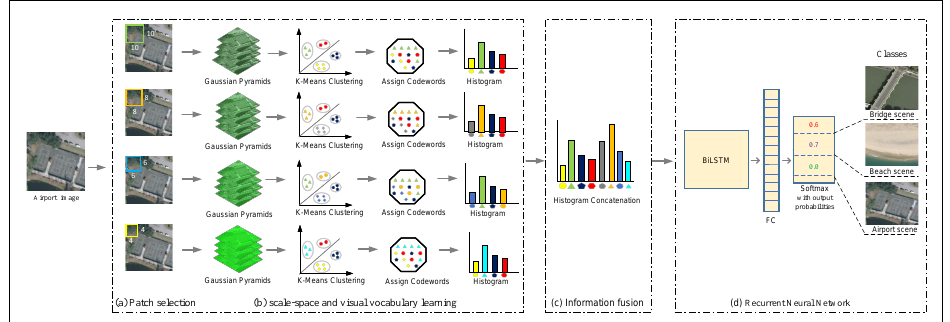
Figure 3. Flowchart of the proposed method. The local patches are selected by a fixed-size sliding window, where green, orange, blue, and yellow rectangles represent the patch sizes of 10 × 10, 8 × 8, 6 × 6, and 4 × 4, respectively. Then the dense interest points are extracted with Gaussian second derivatives without changing the size of the original image and encoded to visual vocabulary through the k-means clustering process. Finally, a concatenated histogram is used as an input for training the BiLSTM